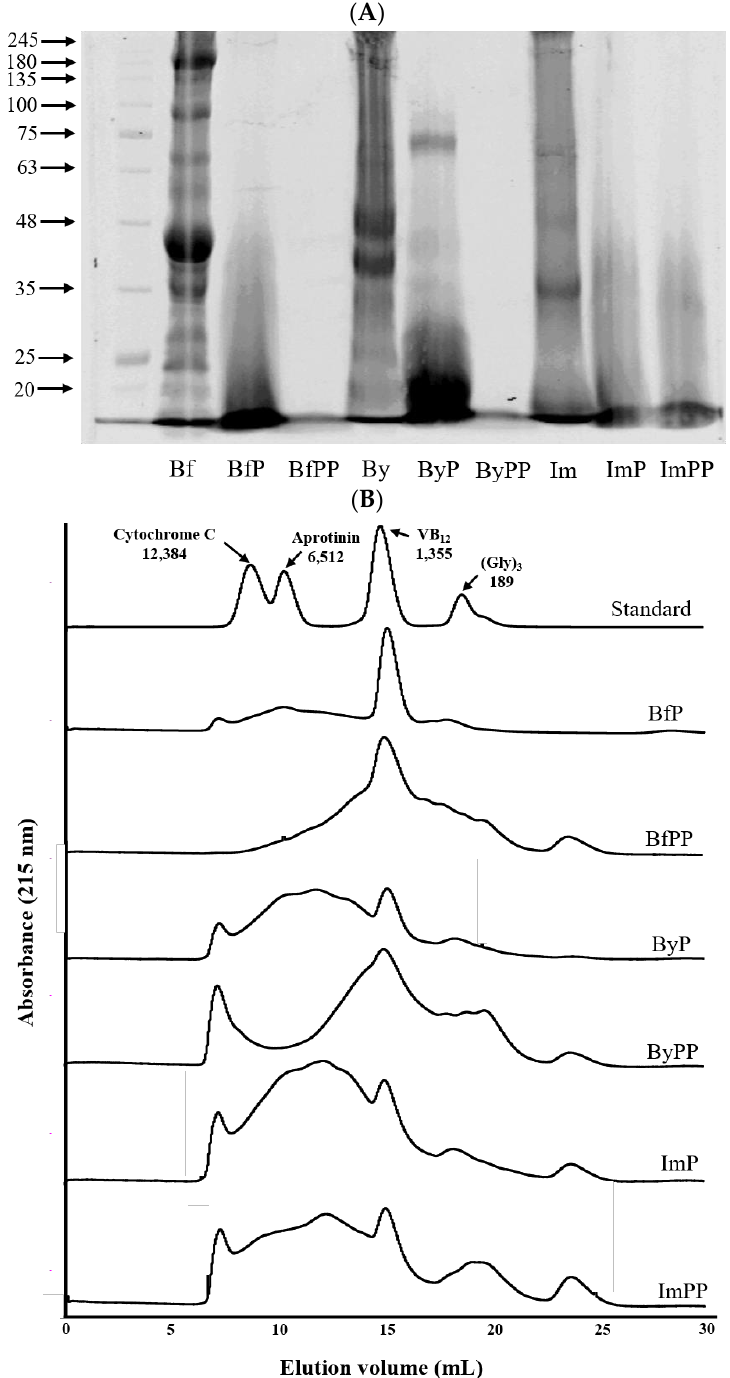
Figure 1. SDS-PAGE ( A ) and size exclusion chromatogram ( B ) of beef and PBMA hydrolysates. Bf